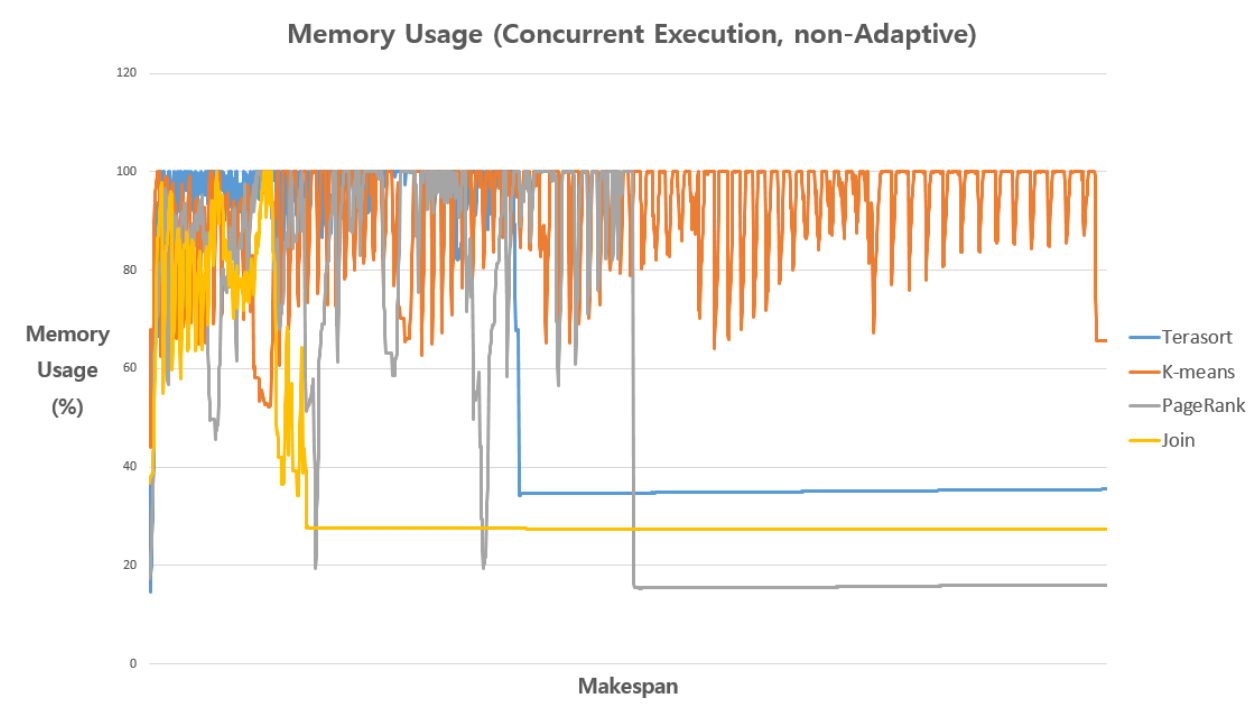
Figure 4. Memory usages of benchmarks in the Fair approach to show an exemplary case of inefficient resource usage patterns.